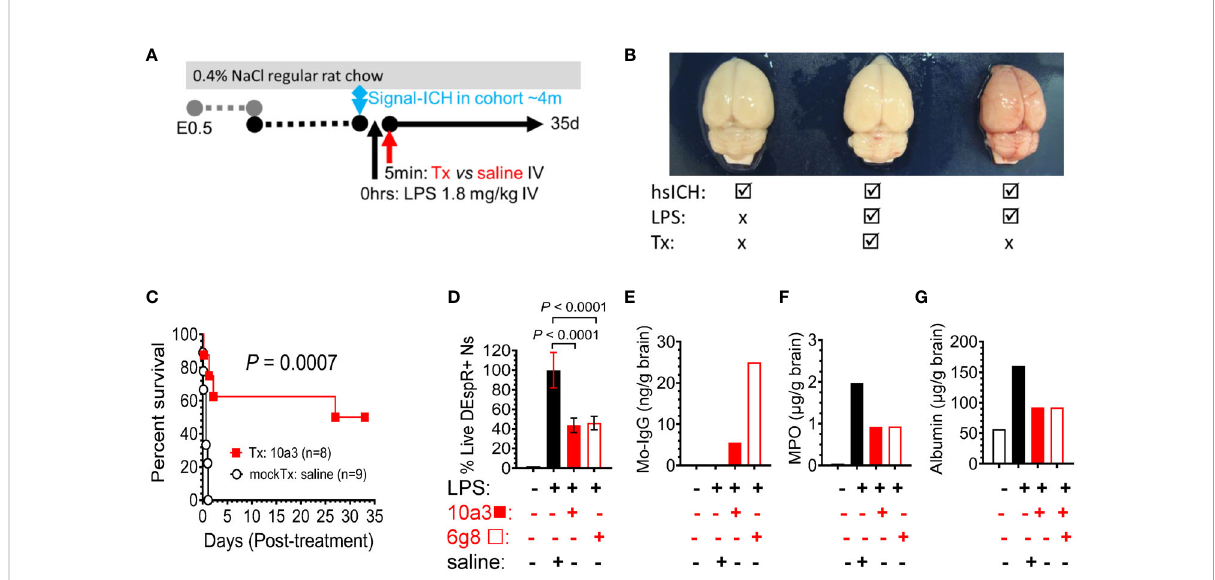
FIGURE 4 DEspR+ neutrophil-subset roles in LPS-induced tissue injury model. (A) Diagram of LPS-induced multi-organ encephalopathy rat model in hsICH-prone rats. Regular salt-challenge (0.4% NaCl regular rat chow) from embryonic day 0.5 (E0.5) in Dahl Salt-sensitive hypertensive rat inducing hypertension-associated neutrophil/endothelial activation. Sub-endotoxic dose of LPS (1.8 mg/kg IV) was infused in study rats after observation of the 1 st intracerebral hemorrhage event in the age-matched rat cohort around 4m of age (signal ICH ~4m). After LPS was infused, treatment (Tx), either anti-DEspR mAb 10a3 or 6g8 as notated, or mock-treatment (mockTx) saline (vehicle) was given. Treated rats with full recovery were monitored until 35 days (35d). (B) Representative post-mortem images of rat brains after intravascular blood volume replaced with 1X PBS. Left, non-LPS-challenged brain; Middle: anti-DEspR (10a3) mAb treated brain after LPS-infusion. Right: LPS-challenge mock- treated control. (C) Kaplan-Meier survival curve of treated (Tx: 10a3, 1 mg/kg IV, n = 8) vs saline mock-treated (mockTx, n = 9) LPS-challenged hsICH rats. Log Rank Mantel-Cox test: P = 0.0007; hazard ratio (Mantel-Haenszel 10.2, 95% CI of ratio: 2.67 – 39.25). (D-G) Analysis of anti- DEspR mAb target engagement and bioeffects. Study groups are designated (+ or -) per agent (left to right): black open bar = control no LPS and no treatments, black bar = reference control LPS + saline, red bar = LPS + 10a3; red open bar = LPS + 6g8 (D) Minimal to no DEspR+ neutrophils in no-LPS rat control. Compared to LPS + saline control (100% reference), anti-DEspR mAbs 10a3 and 6g8 reduce survival of DEspR + neutrophils (n = 6 replicates/group), concordant with target engagement and bioeffects in peripheral DEspR+ neutrophils ex vivo . (E) Brain membrane-bound protein levels of mouse-speci fi c immunoglobulin (IgG) in 10a3 or 6g8 mAbs showing brain target engagement, 6g8 > 10a3. (F, G) Analyses of brain non-membrane bound proteins by ELISA detect reduced brain levels of (F) neutrophil-derived myeloperoxidase (MPO) in 10a3 and 6g8-treated rat brains compared to LPS + saline mockTx rat brain, and (G) reduced levels of albumin as a marker of edema in the brain. ng/g brain, nanogram per gram brain; m g/g brain, microgram per gram